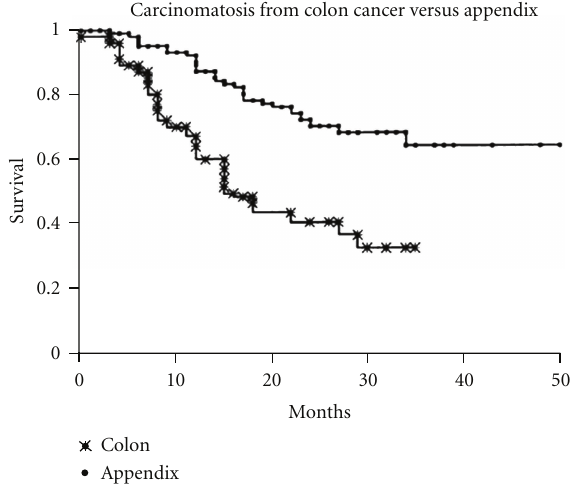
Figure 4: Comparison of survival of colon and appendiceal peri- toneal metastases in patients having the same treatments